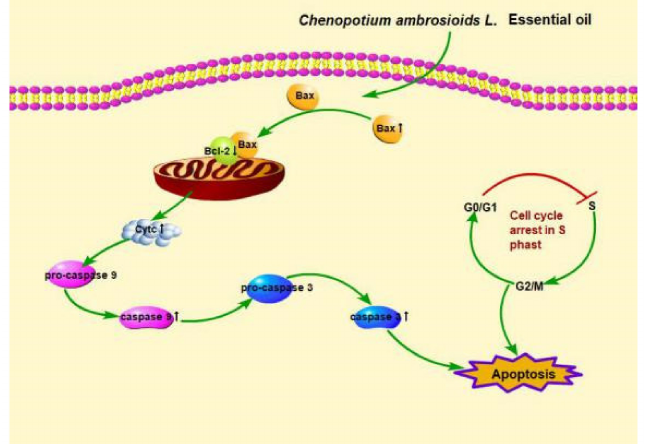
Figure 3. Pictorial representation depicting the mechanism of action of C. ambrosioides essential oil in L02